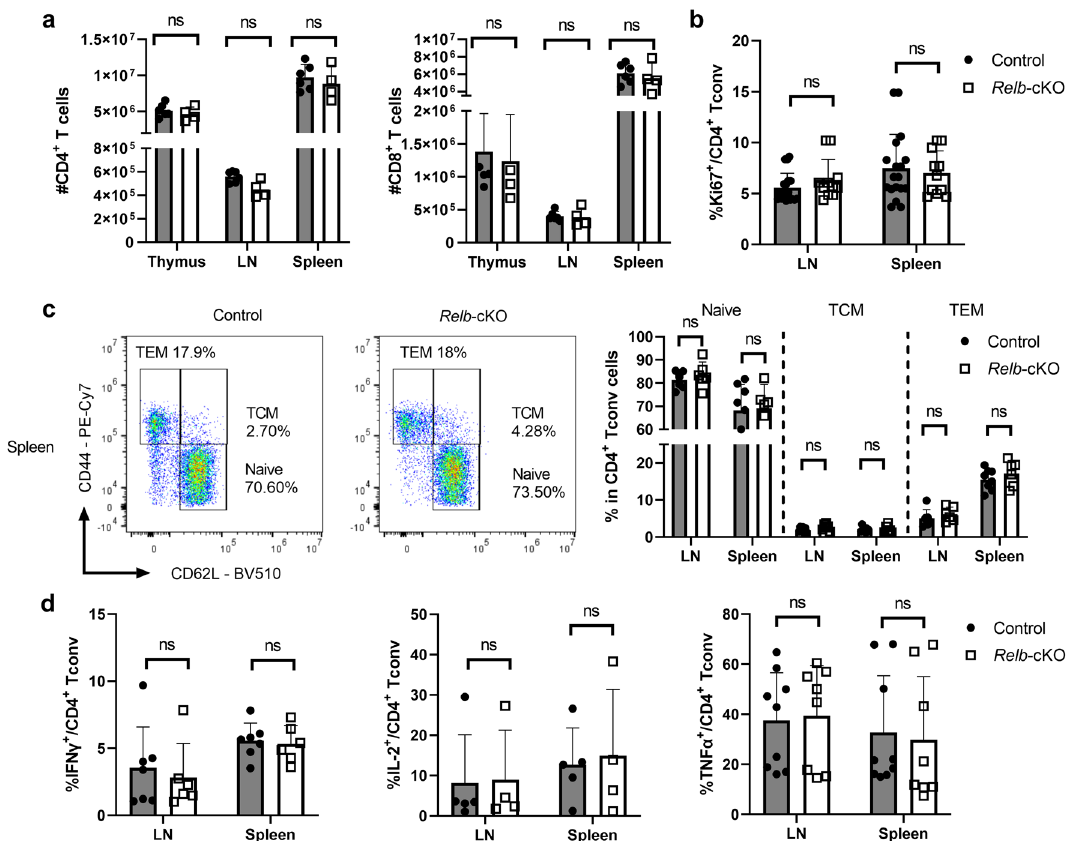
Figure 1. Conditional ablation of Relb in T cells does not impair their homeostasis at steady-state. Thymus, spleen and peripheral lymph nodes (LN) from CD4 cre (control) and CD4 cre Relb F/F ( Relb -cKO) mice were analyzed by flow cytometry. ( a ) Quantification of live TCR-β + CD4 + and CD8 + cells. ( b ) Proportion of Ki67 + in CD4 + Foxp3 - (Tconv) cells. ( c ) Representative dot plots in the spleen and cumulative data of CD44 and CD62L expression in Tconv cells. T CM : T central memory; T EM : T effector memory. ( d ) Cytokine expression by Tconv cells following restimulation with PMA/ionomycin. Each dot represents an individual mouse from 3-5 experiments. Mean + /- SEM is shown. ns :